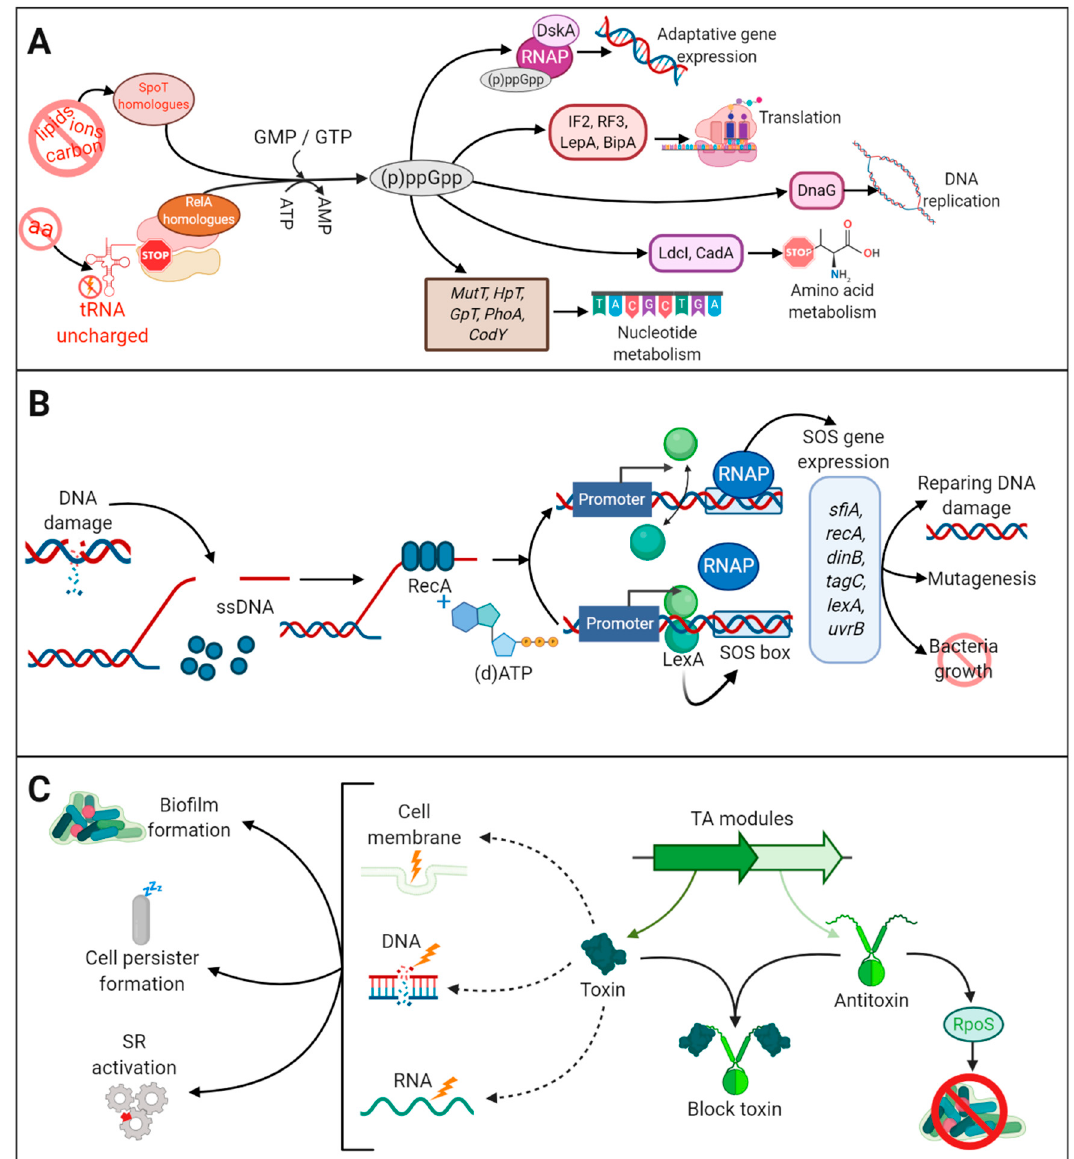
Figure 3. The stringent response, toxin-antitoxin, and SOS response pathways. ( A ) The stringent response (SR) is triggered by several stress conditions (amino-acid, carbon and iron deprivation or membrane damage) that activate the production (p)ppGpp by the synthetases RelA and SpoT and homologues. (p)ppGpp reprograms cell metabolism through the interaction with proteins involved in translation, transcription, replication, amino-acid metabolism, and nucleotide metabolism. ( B ) The SOS response is triggered by damaged DNA. Single-stranded (ssDNA) is detected by RecA. In the presence of (d)ATP, RecA is activated causing self-cleavage of LexA. LexA is a dimer that represses the transcription of SOS genes, which harbor